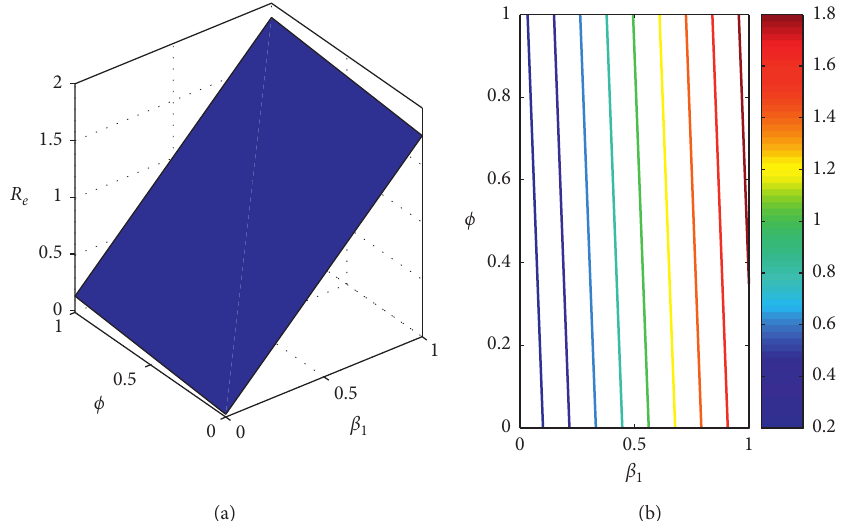
Figure 4: (a, b) As transmission rates ϕ and β increase, there is an increase in disease epidemic. More people are infected with Shigellosis as a 1 result of exposure to the environment or infectious